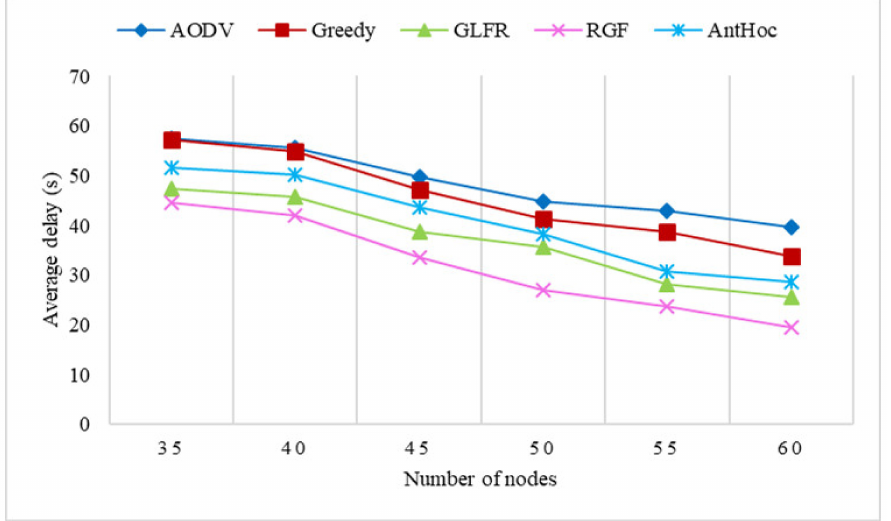
Figure 18. The effect of the number of nodes on the average